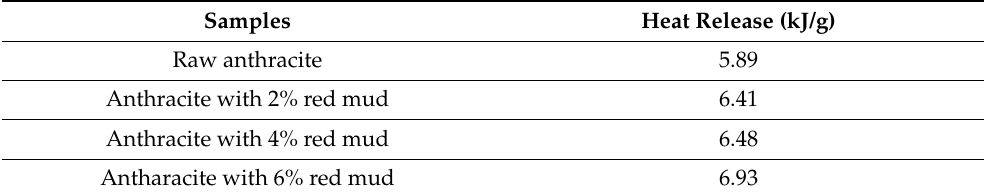
Table 5. Effect of red mud on anthracite combustion